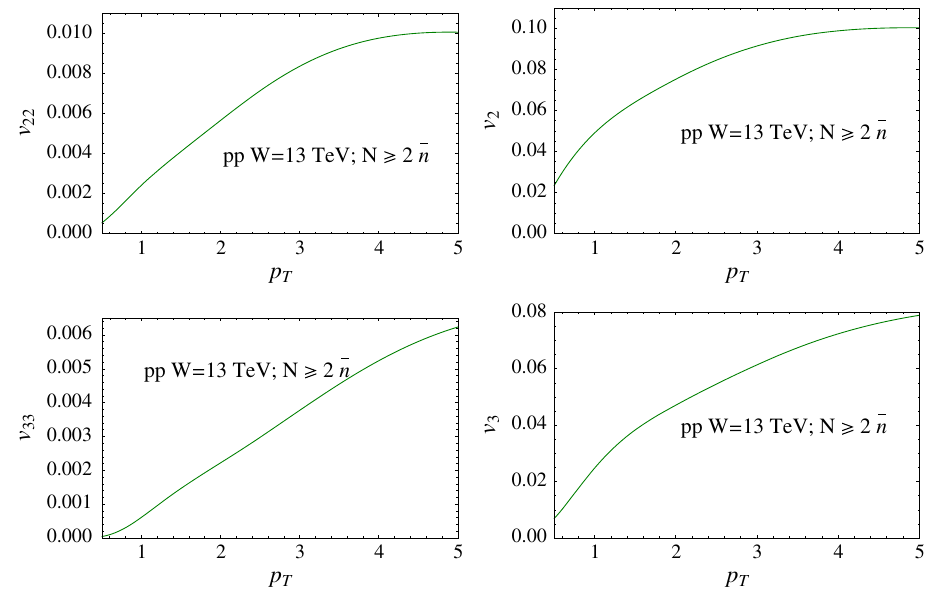
Fig. 13 Our model for v nn and v n versus p T at W =